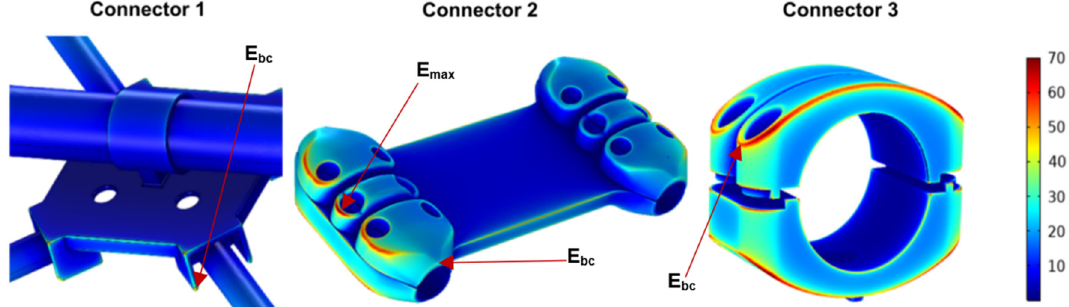
Figure 5. Electric field (kV/cm) at the connector surface.